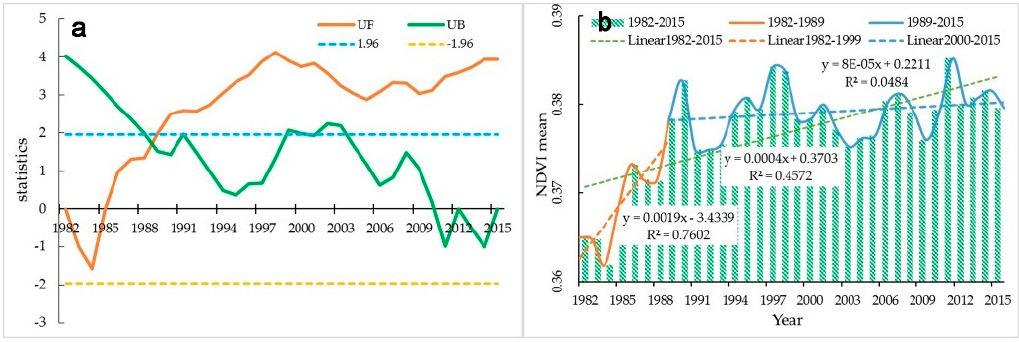
Figure 2. Mann–Kendall mutation test ( a ) and annual NDVI trends from 1982 to 2015 ( b ).